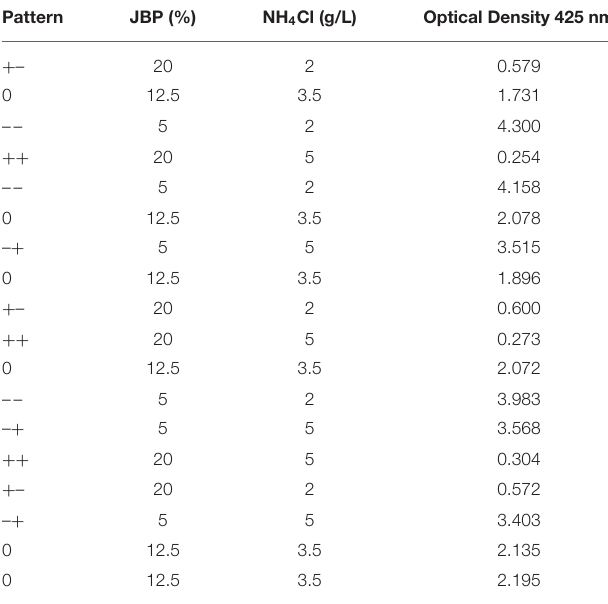
TABLE 3 | Optical Density at 425nm of C. necator in different formulations of biomass production culture media. Pattern JBP (%) NH 4 Cl (g/L) Optical Density 425